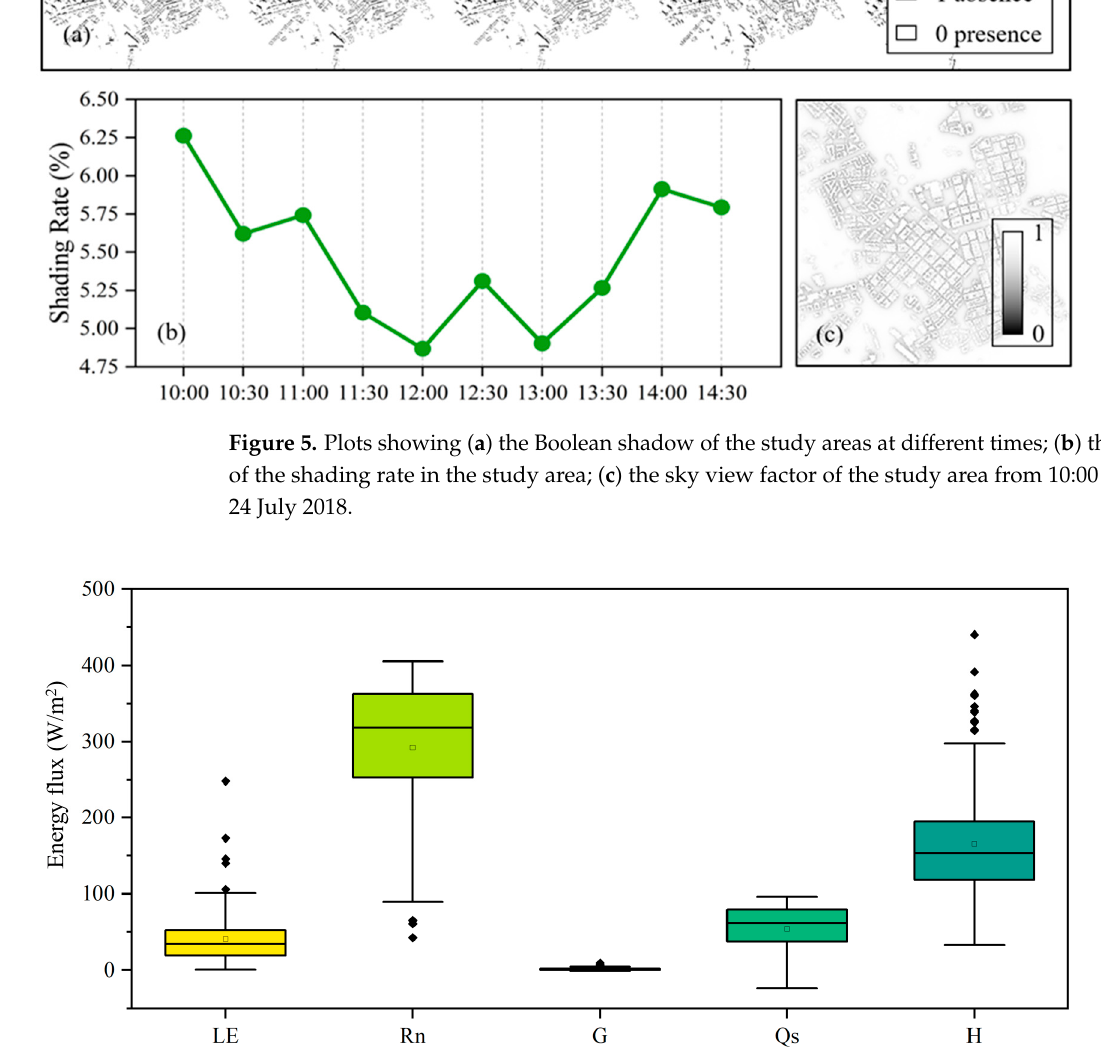
Figure 7. The sums of the observed latent and sensible heat by the EC system are compared with the net energy input (( a ) ignoring the urban canopy storage; ( b ) considering the urban canopy stor- age heat). 3.2. Performance of the Proposed PT-Urban Model The optimal m1, Topt, and β values for the Hotel Torni site are 1.405, 18.7, and 0.55, respectively. Figure 8 compares the estimated footprint-weighted LE with the observed LE by the EC system during the calibration and validation periods. For the calibration, the estimated half-hourly LE values were highly correlated with the observed values, with an R 2 value of 0.59. The fitted linear correlation line between the observed and estimated half- hourly LE values without intercept was slightly lower than 1:1, with a slope of 0.95. The RMSE and relative bias of the estimated half-hourly LE values were 14.67 W m − 2 and – 4.5%, respectively. During the validation, the RMSE, relative bias, and R 2 were 14.70 W m − 2 , –11.1, and 0.58, respectively, which were close to those of the calibration. Generally, the PT-Urban model performed satisfactorily at the Hotel Torni site.